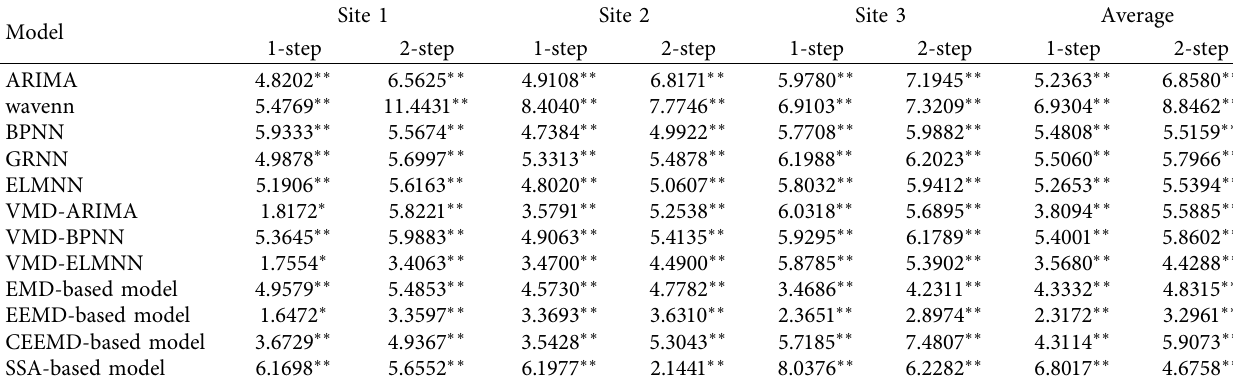
Table 8: The statistics value of DM test for experimented models.